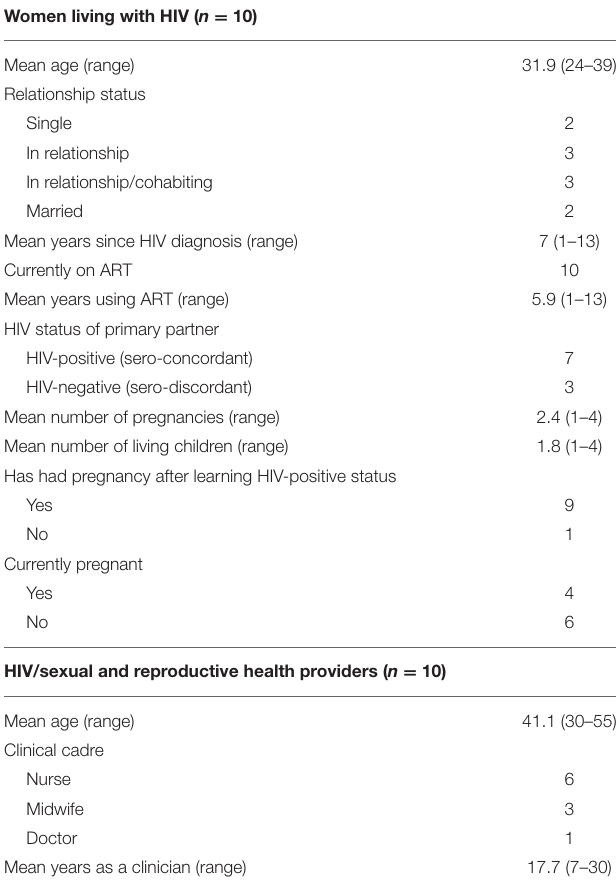
TABLE 1 | Demographic characteristics of recruited participants. Women living with HIV ( n =